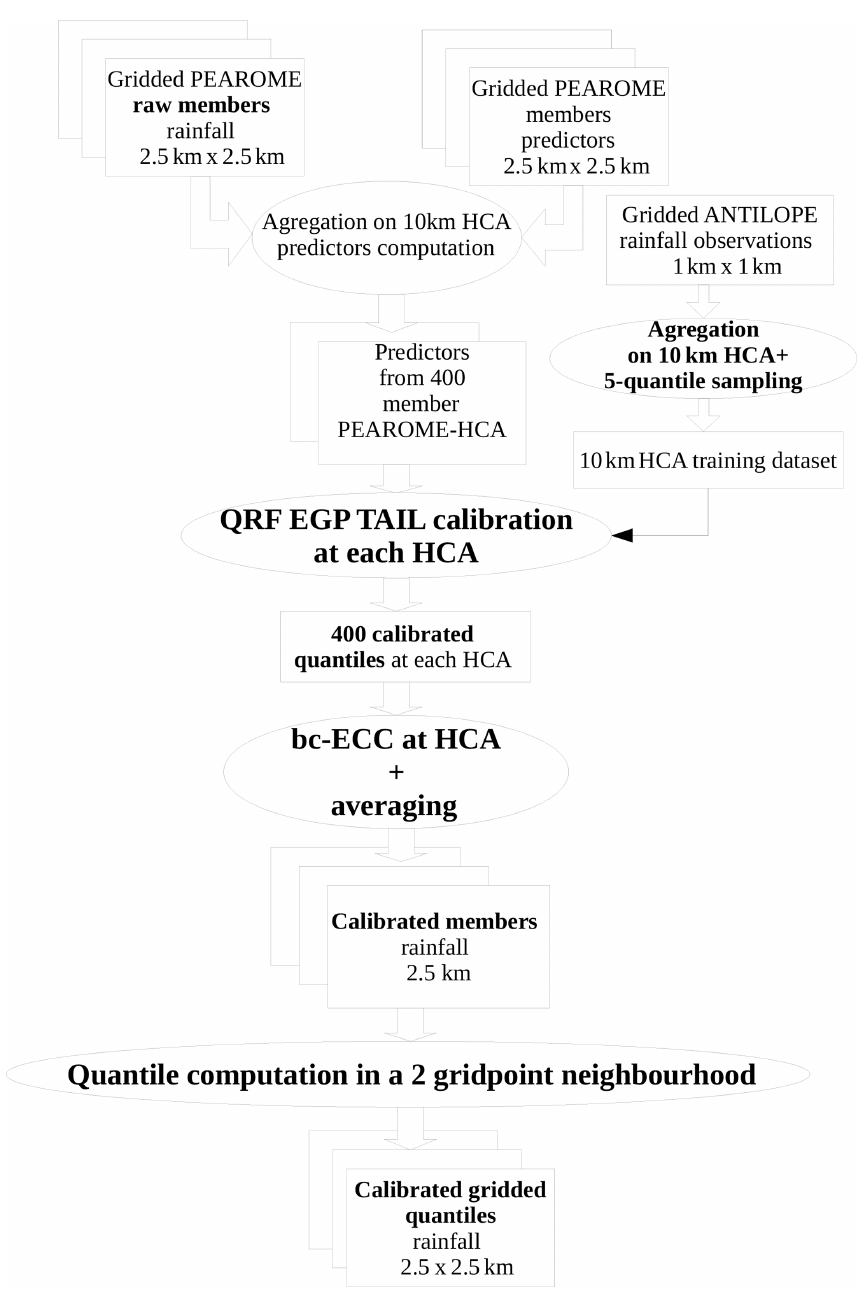
Figure 2. Flowchart of the hourly rainfall post-processing chain.